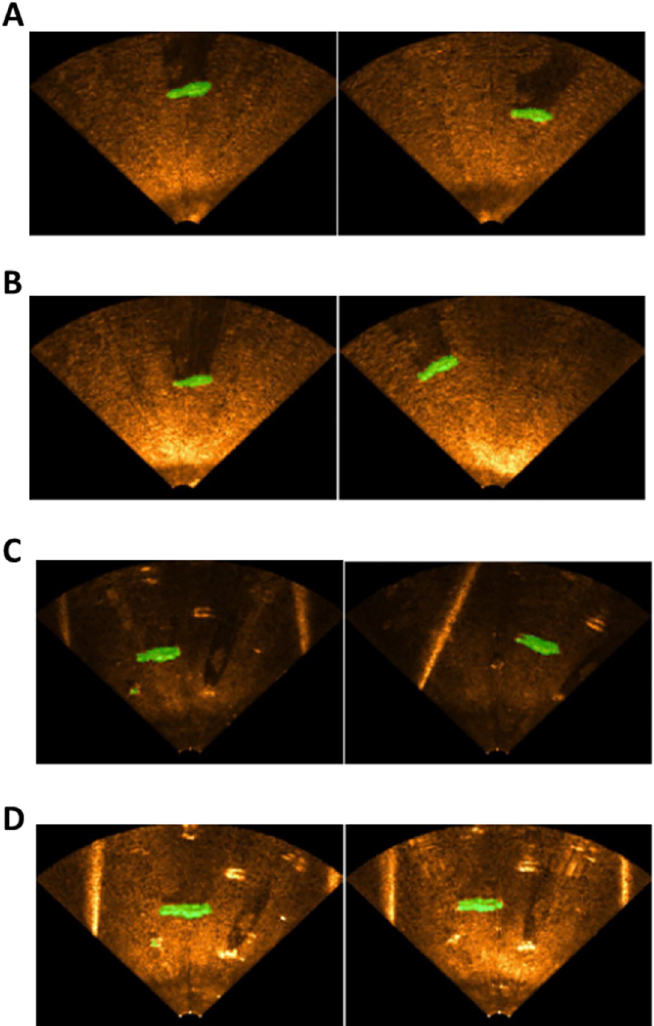
Fig 10. USI segmentation results (left: Semantic segmentation NN trained using real USI, right: Semantic segmentation NN trained using real USI and synthetic USI). (A) Reservoir low sensitivity, (B) Reservoir high sensitivity, (C) Pool low sensitivity, (D) Pool high